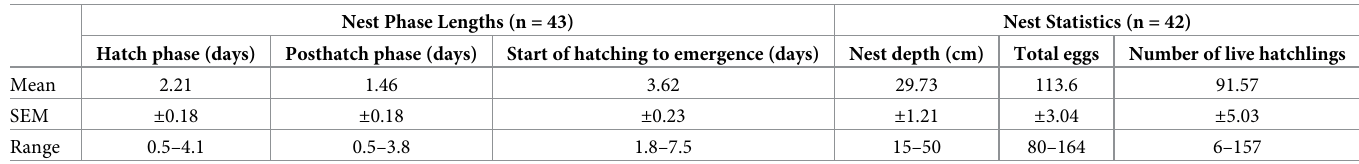
Table 1. Nest phase lengths and summary statistics for viable Caretta caretta TurtleSense monitored nests between 2014–2017 on Hatteras Island,